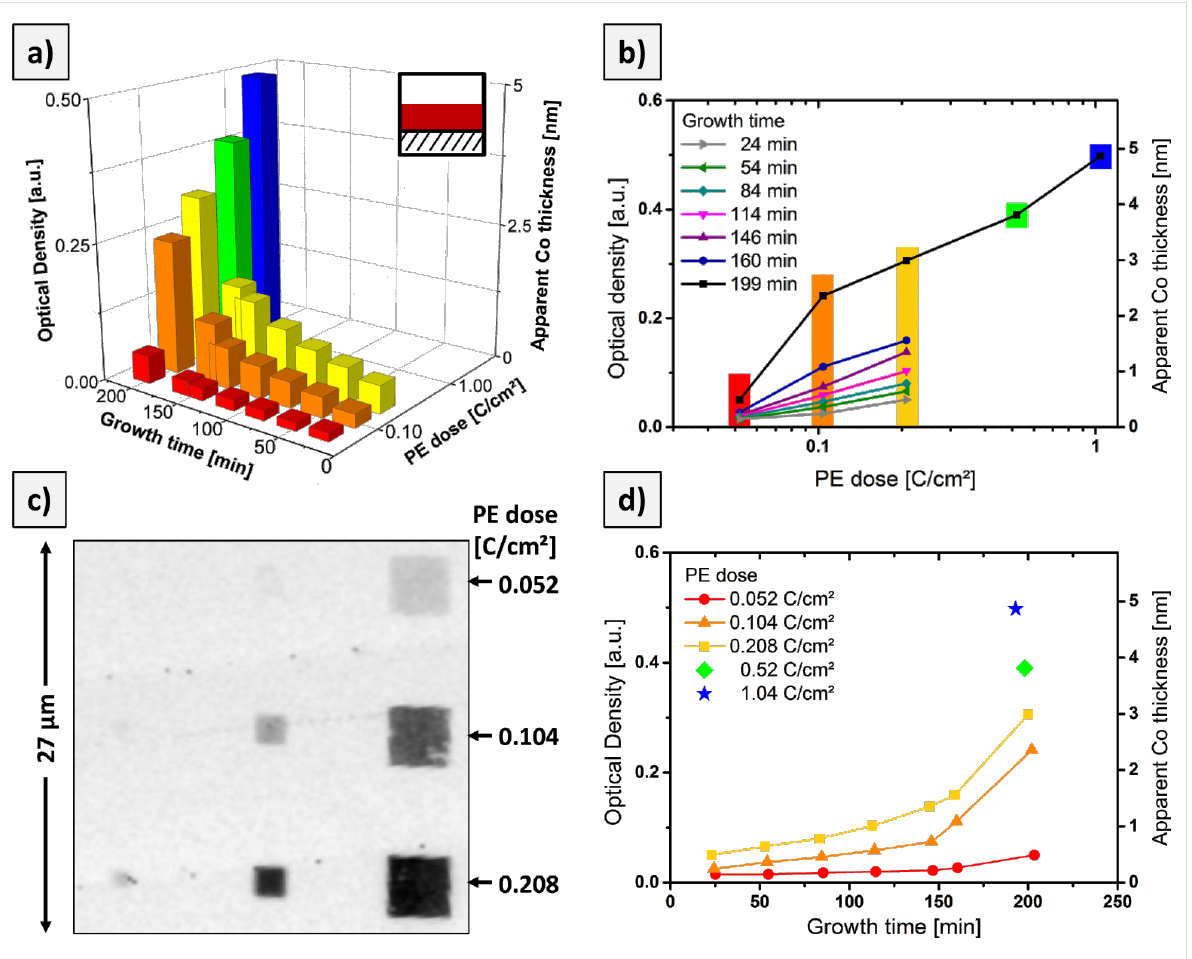
Figure 5: Evaluation of the X-ray absorption data for the growth of Co-containing deposits by EBID plus autocatalytic growth upon Co(CO) 3 NO dosage. a) Optical density (left vertical axis) and apparent Co thickness (right vertical axis) of 4 × 4 µm 2 squares vs growth time and PE dose during EBID. b) and d) detailed graphs of the observed growth behavior; the color code identifies the respective data set. c) STXM micrograph (transmitted intensity) of a set of deposits prepared with different PE doses, but the same growth time of about 160 min obtained at a photon energy of 780.4 eV. See text for the definition of the apparent Co